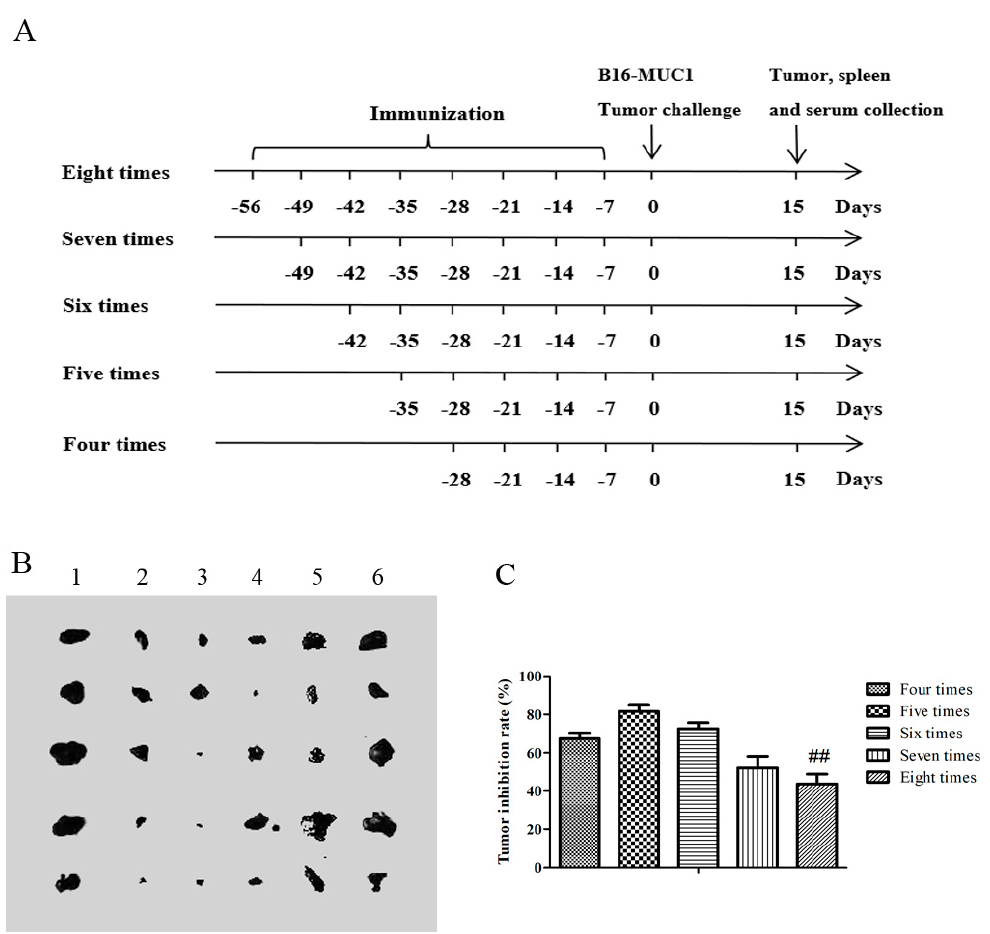
Figure 1. The antitumor e ff ect of the recombinant mucin1-maltose-binding protein (MUC1-MBP) vaccine in the tumor-bearing preventive mouse model. Mice ( n = 5) received di ff erent numbers of subcutaneous immunizations at 7-day intervals, and then were subcutaneous injected (s.c.) with 5 × 10 5 human MUC1 -overexpressing mouse melanoma B16 cells (B16-MUC1) melanoma cells one week after the final immunization. The mice were euthanized day 15 after tumor inoculation. ( A ) The experimental workflow of the preventive mouse model. ( B ) The photographs show the tumors dissected from the mice; “1” represents the negative control (NC) group; “ 2, 3, 4, 5, and 6” represent the vaccine groups immunized four, five, six, seven, and eight times, respectively. ( C ) The tumor inhibition rate. Tumor inhibition rate (%) = (1 − experimental group tumor weight / control group) × 100%. ## p < 0.01 vs. the group immunized five times.